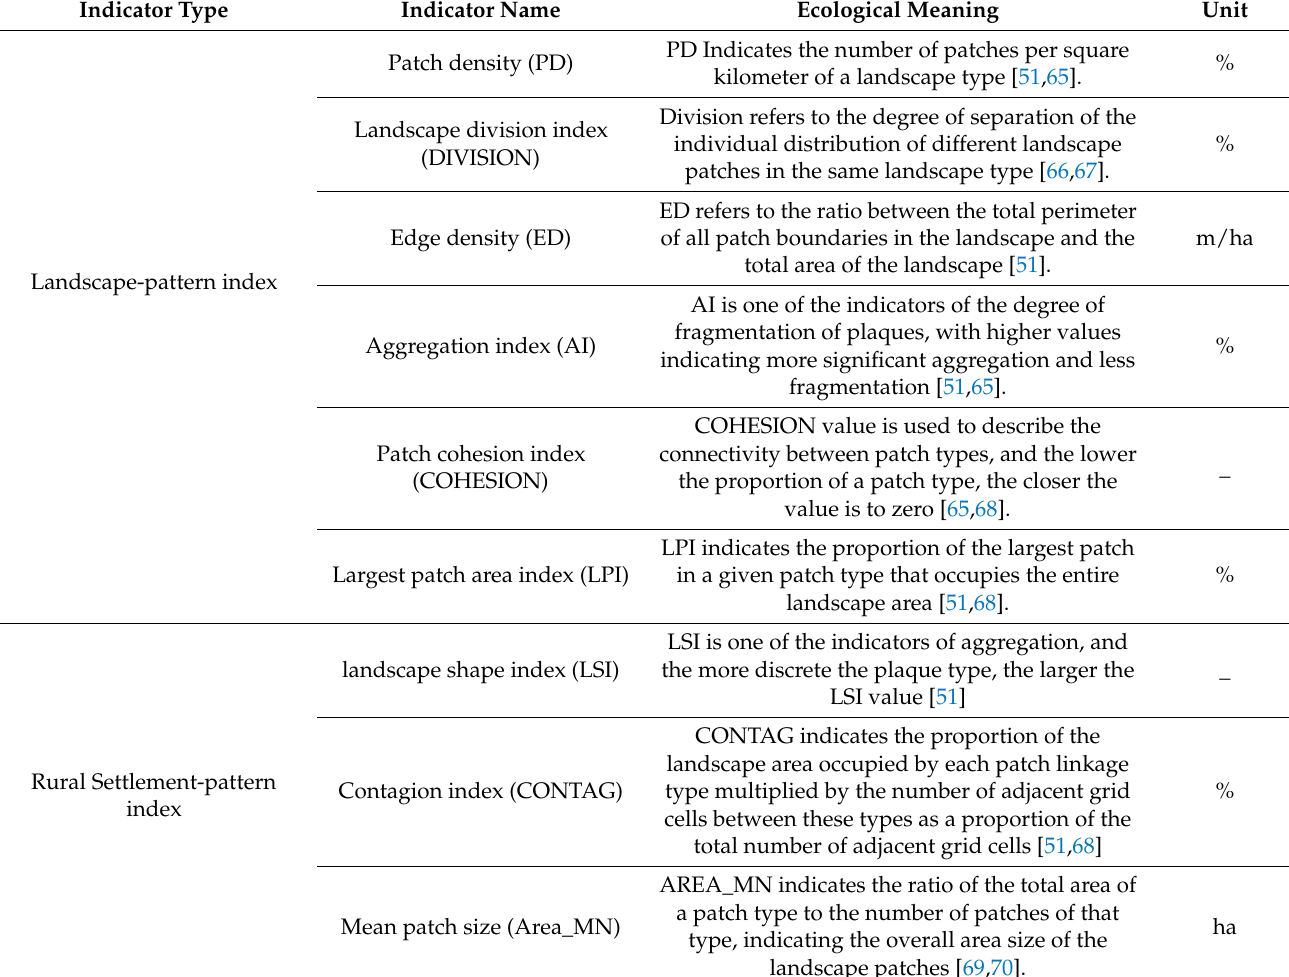
Table 1. Landscape Fragmentation and Settlement Pattern Indicator